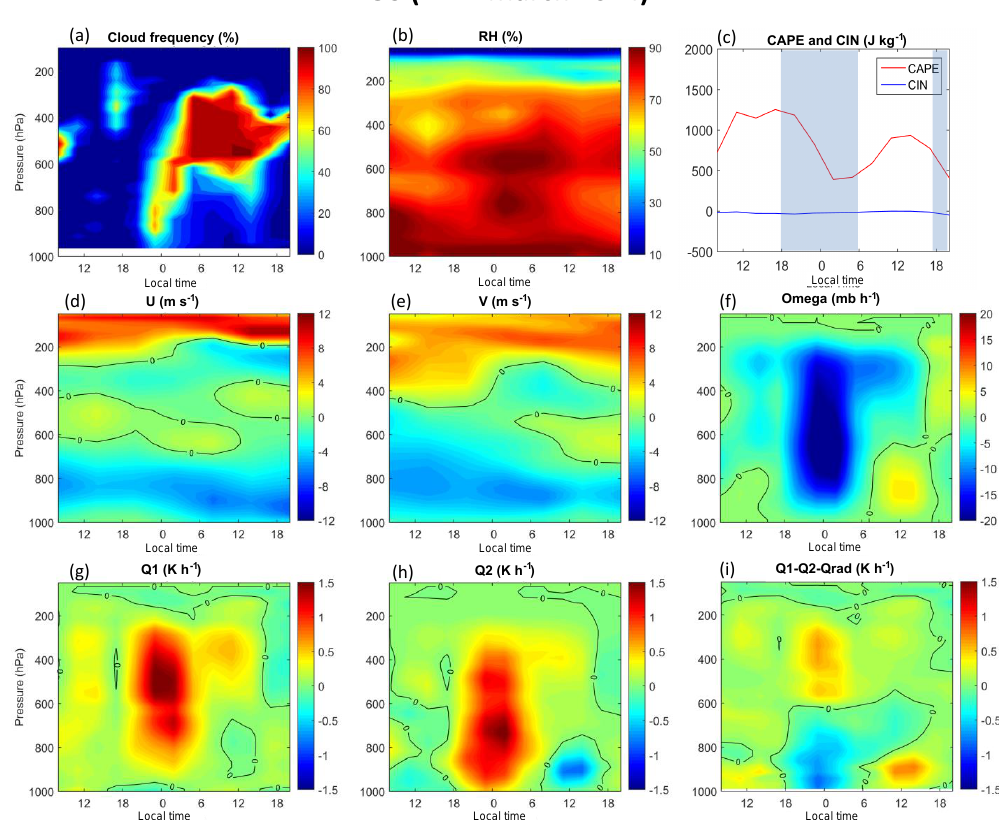
Figure 12. Similar as Fig. 10 but for the BOS